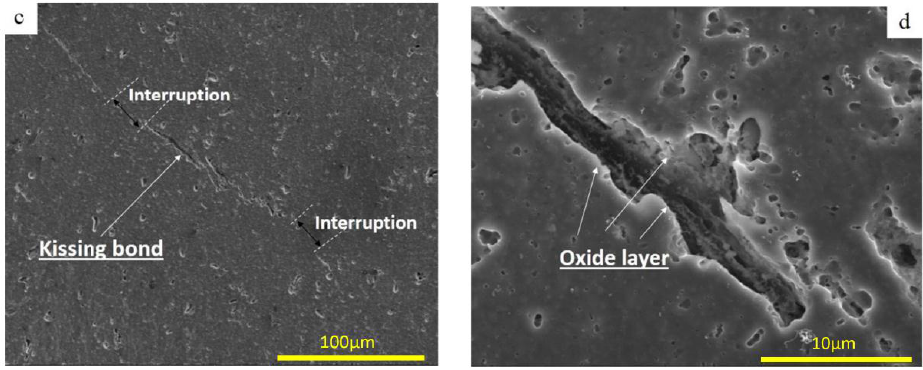
Figure 12. Kissing bond in 89 mm/min: ( a , b ) macrograph of kissing bond in root; and ( c , d ) SEM image of kissing bond.